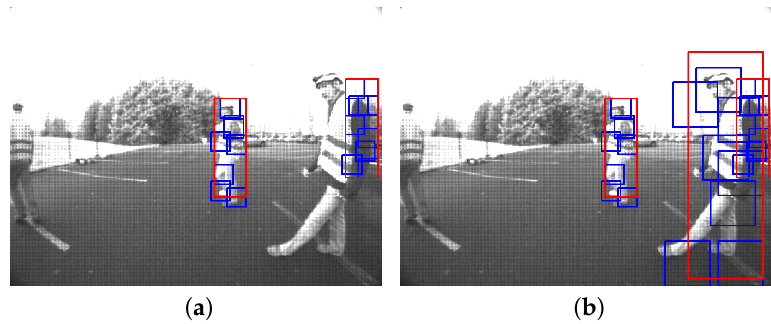
Figure 14. Examples of detection results with ( a ) the DPM approach and ( b ) the adaptive-DPM